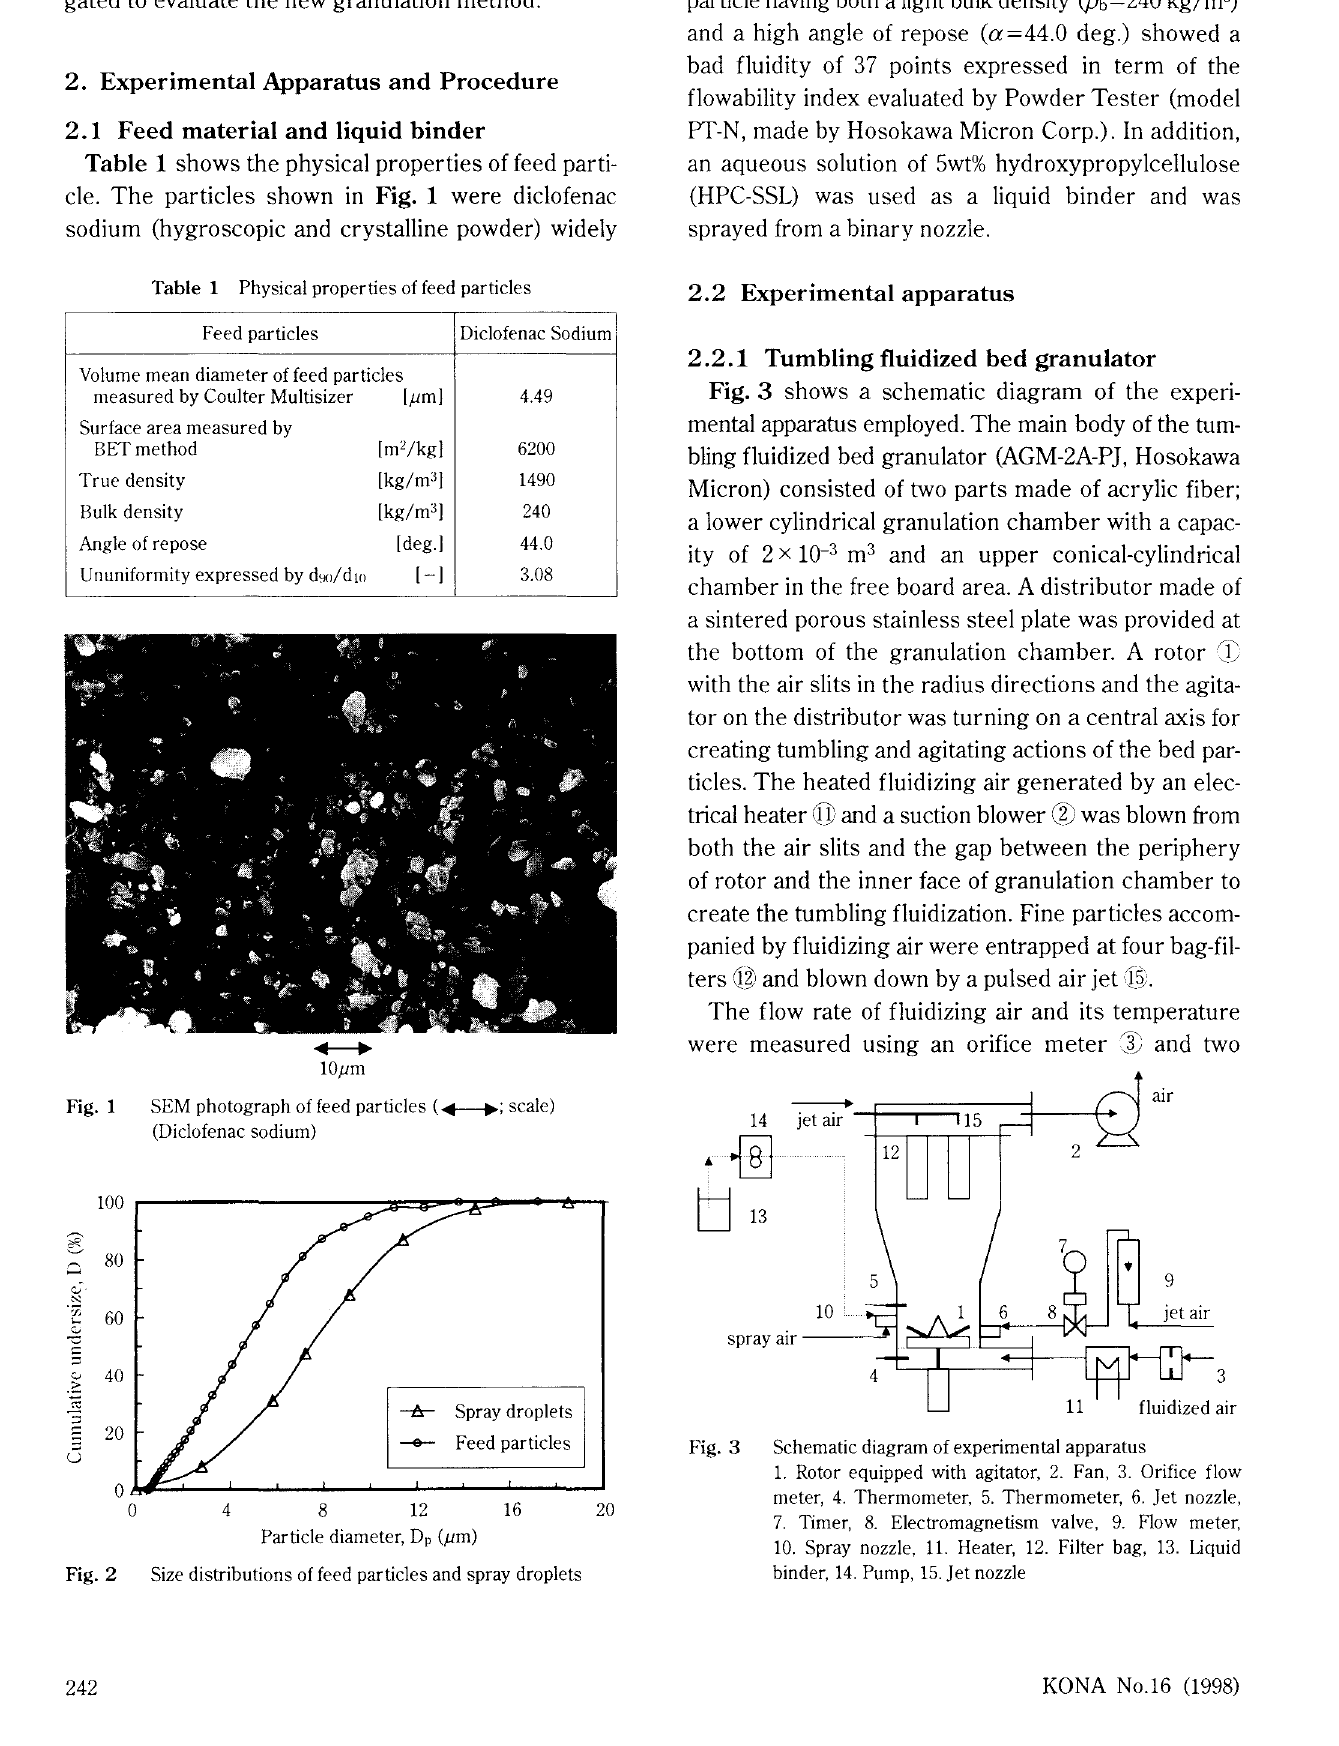
Size distributions of feed particles and spray droplets